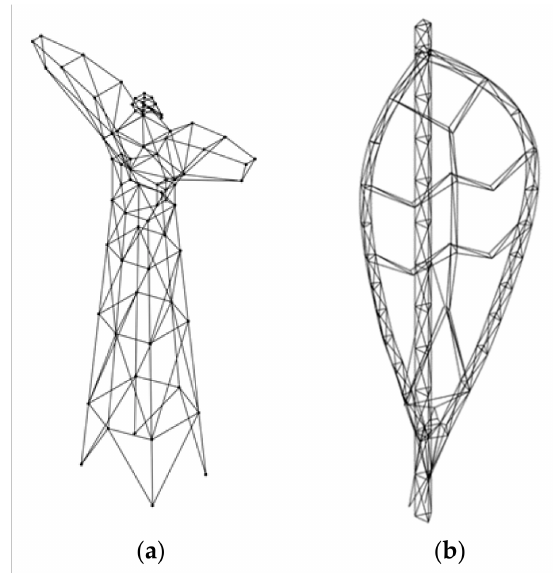
Figure 14. Initial reticular structure. ( a ) Eagle; ( b )